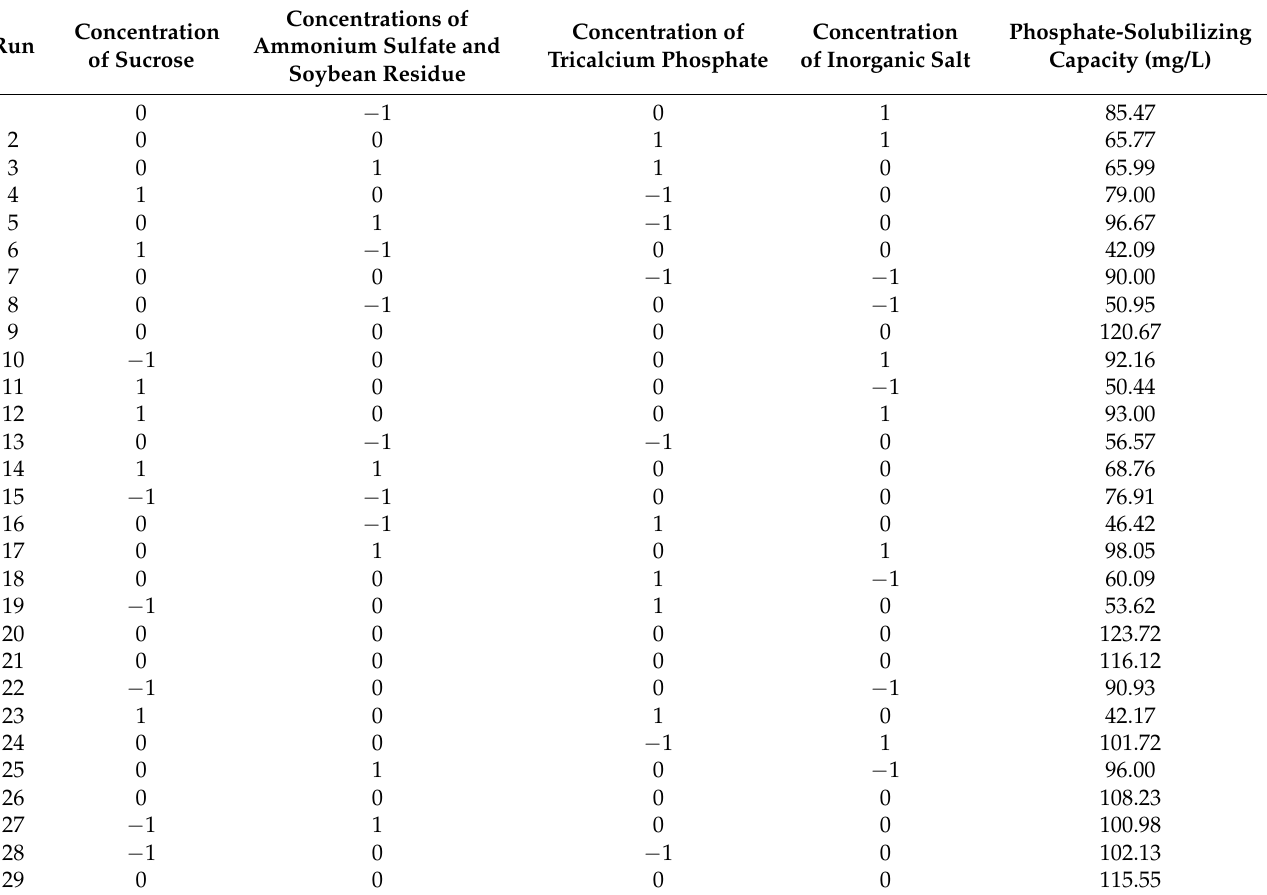
Table 1. Design and results of Box–Benhnken